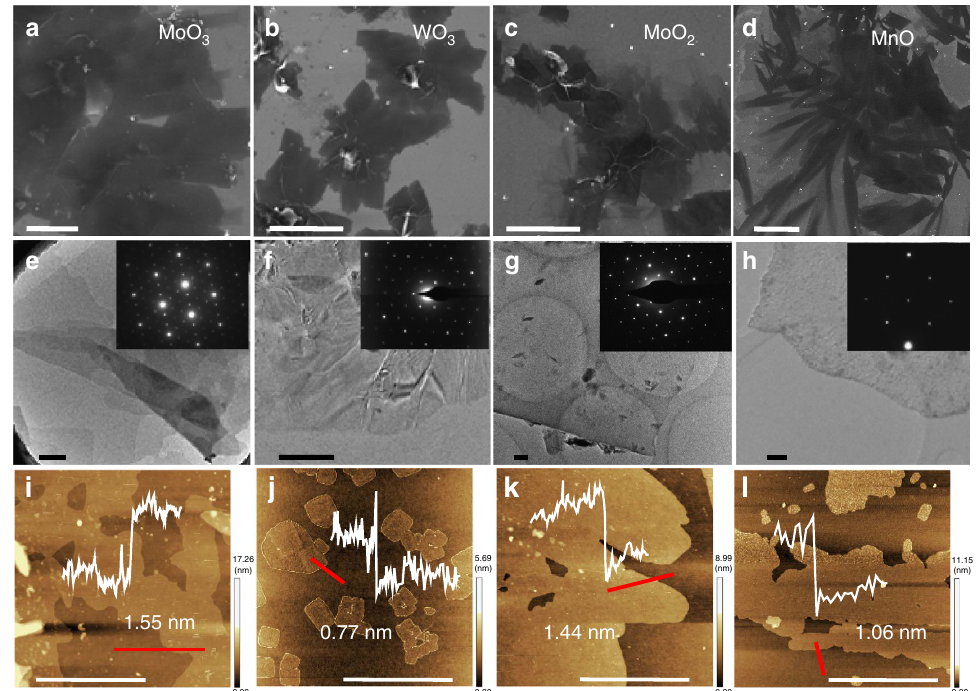
Figure 2 | High-quality 2D oxide synthesized using the salt-assisted templating method. SEM images of h -MoO3 ( a ) h -WO3 ( b ) MoO2 ( c ) and MnO ( d ). Scale bar, 20 m m ( a , b ); 100 m m ( c ); 50 m m ( d ). Low-resolution TEM images of h -MoO3 ( e ), h -WO3 ( f ), MoO2 ( g ) and MnO ( h ). Scale bar, 500nm (for all of the TEM images). The insets show the corresponding selected area electron diffraction patterns. AFM images of h -MoO3 ( i ), h -WO3 ( j ), MoO2 ( k ) and MnO ( l ). The insets show the corresponding thickness of the 2D oxide. Scan lines are shown in red. Scale bar, 1 m m ( i , k ); 5 m m ( j , l ).